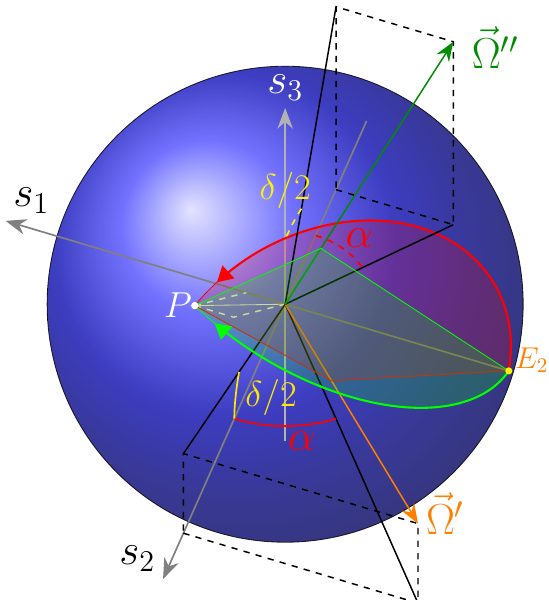
Figure 16. Overall device effect, for the two